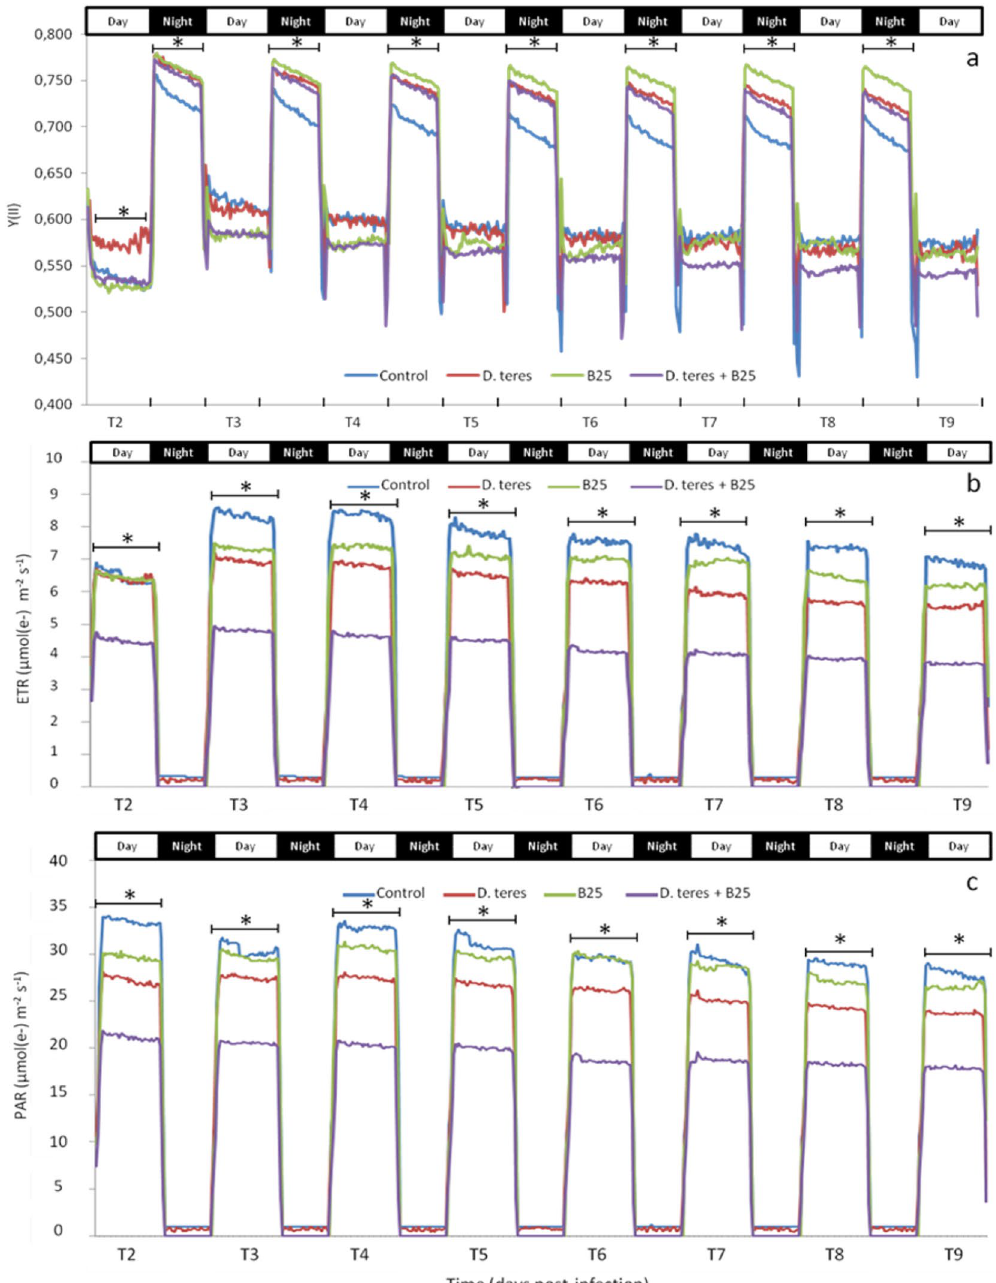
Figure 2. Monitoring of the Y(II) ( a ), ETR ( b ) and PAR ( c ) parameters as a function of time for different experimental conditions: control barley (blue), barley infected with D. teres (red), barley bacterized with strain B25 (green) and barley infected and bacterized (purple). The data correspond to the mean of three independent experimental replicates, each with three or four plants per treatments (n = 9 or 12). Data were obtained from 2 to 9 dpi noted in this figure T2 to T9. Measurements were taken every 20 min. Asterisks (*) show the significant differences between the experimental conditions during a period of day or night for a time-point (Student’s test, p value <